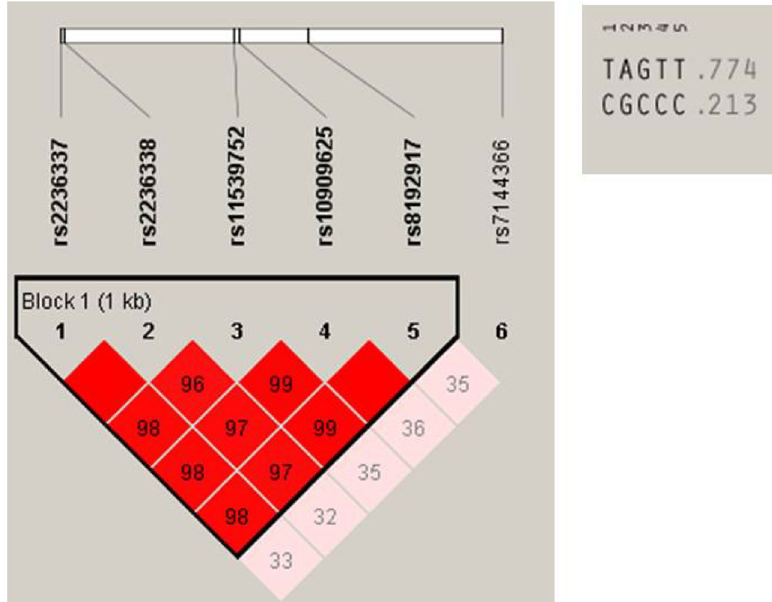
Figure 1. Linkage disequilibrium of GZMB .